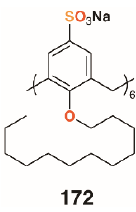
Figure 27. Shah’s nanostructure-forming calixarene.